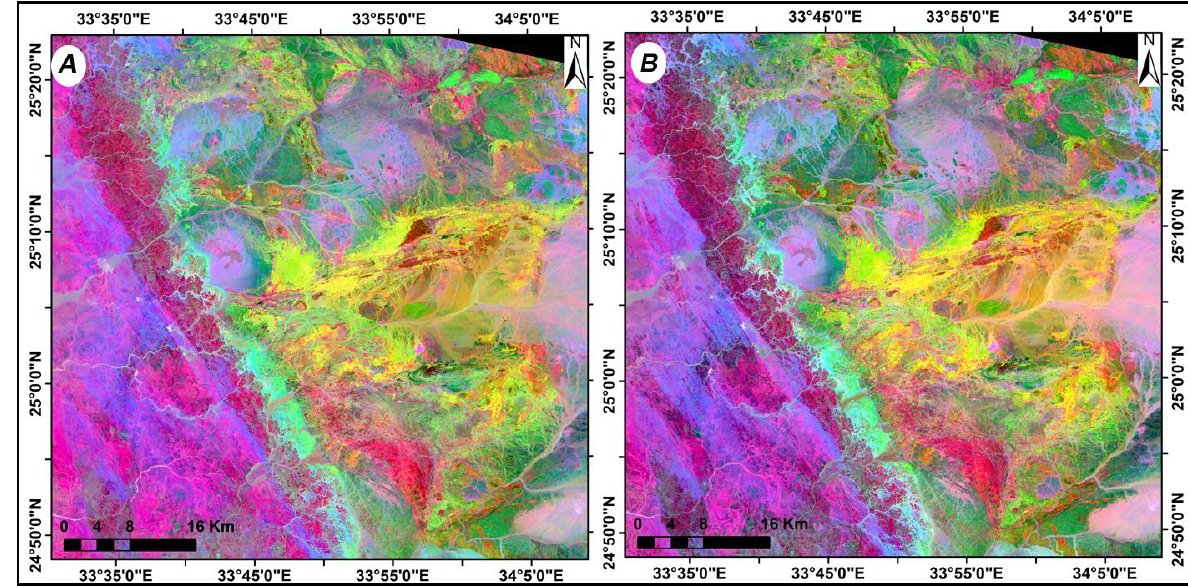
Figure 14. FCC band ratio images of ( A ) Landsat-8 (R: 6/7, G: 5/6, and B: 4/2) and ( B ) predicted hyperspectral data (R: 142/201, G: 53/142, and B: 30/15).